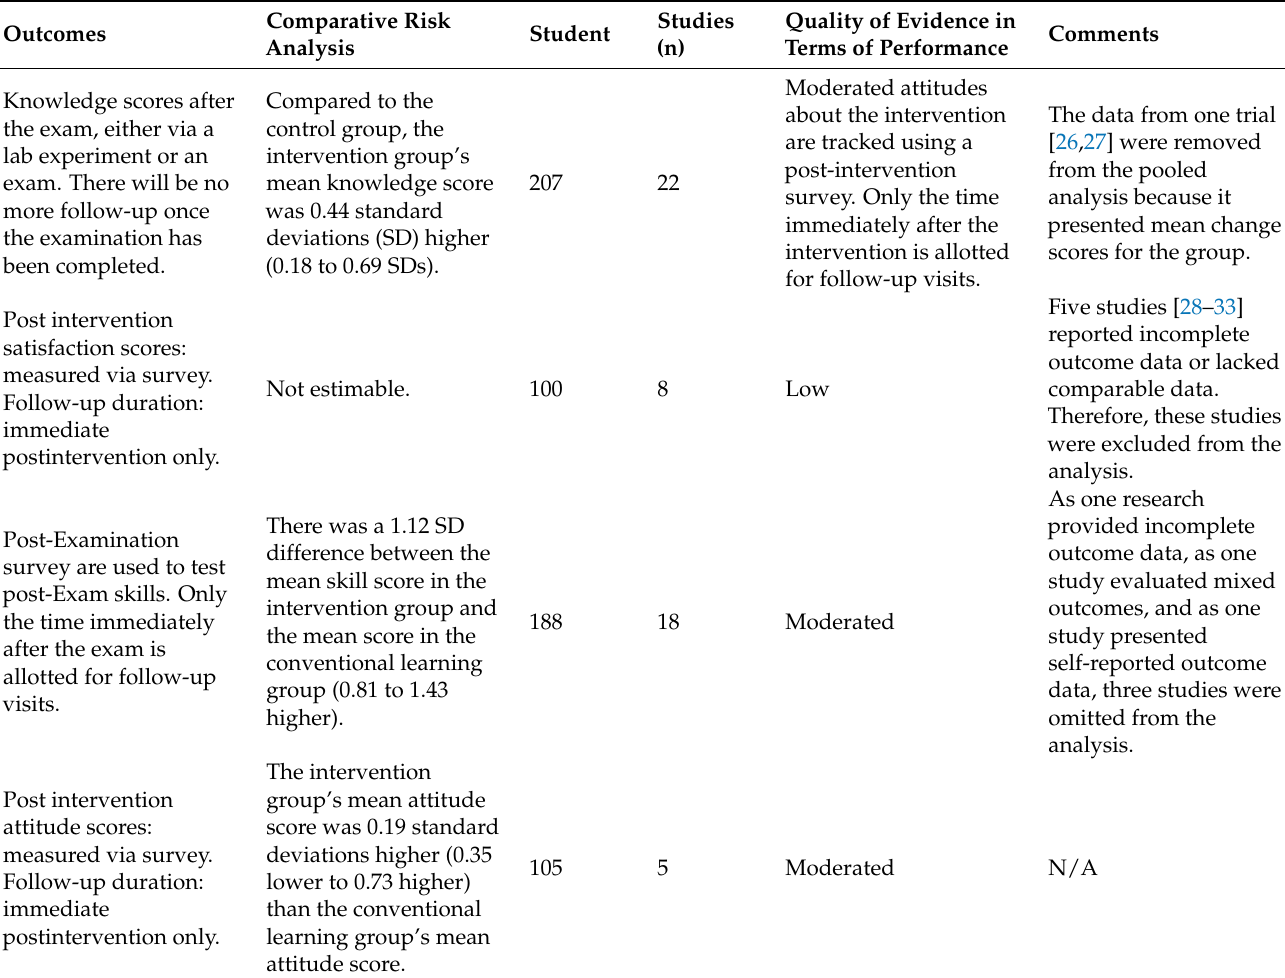
Table 8. Comparative analysis of result with exiting method.